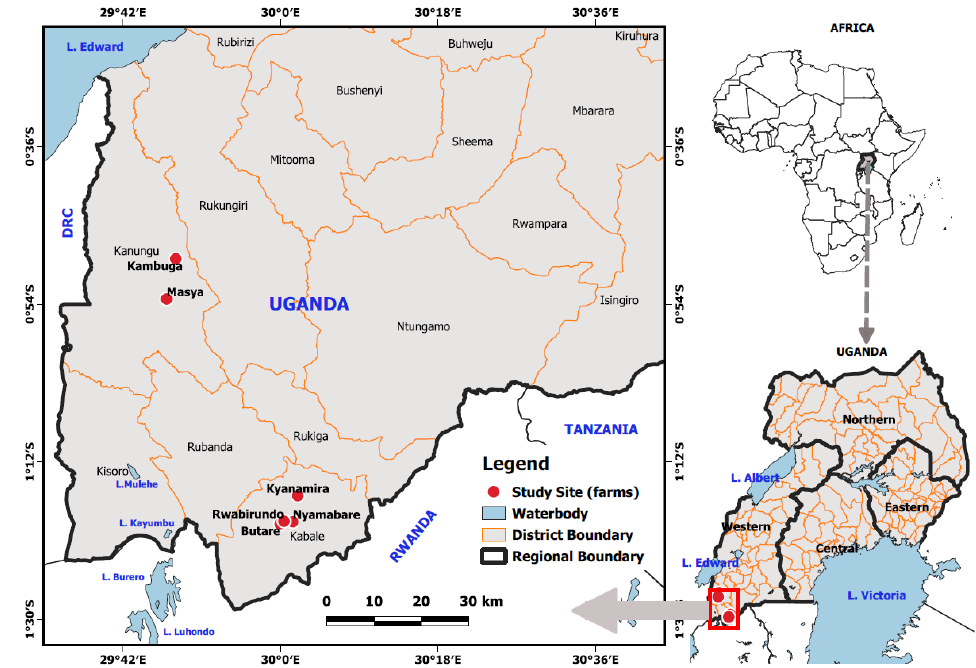
Figure 1. Map showing the sampling fish farms.